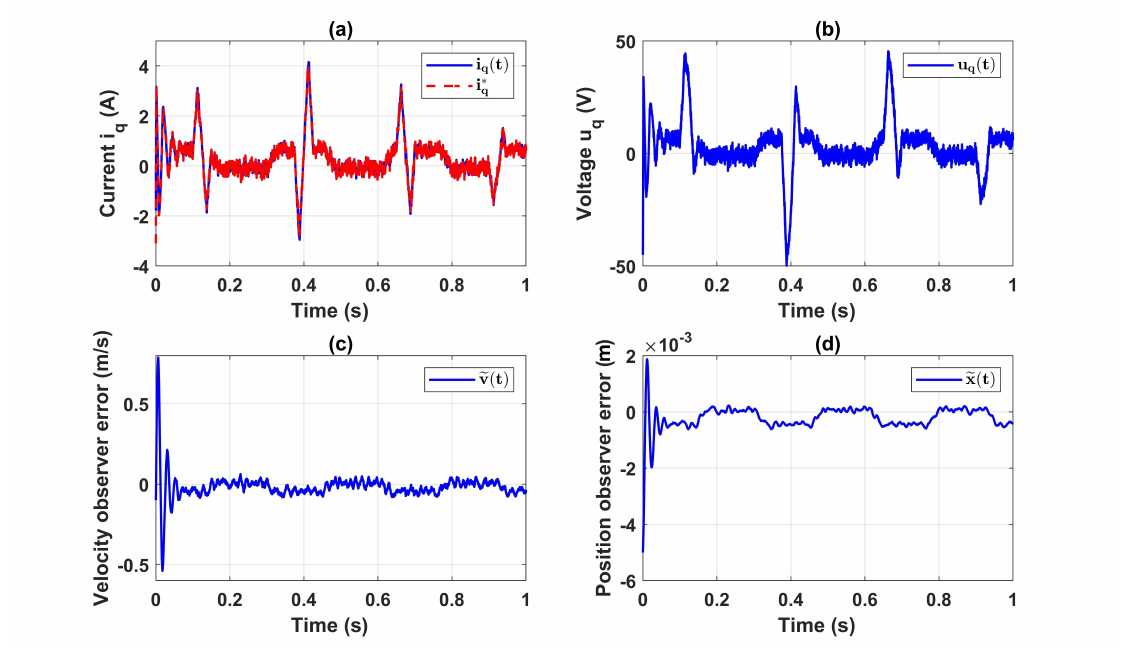
Figure 7. Effects of noise measurement in time behavior of ( a ) quadrature current, ( b ) quadrature voltage, ( c ) velocity observer error and ( d ) position observer